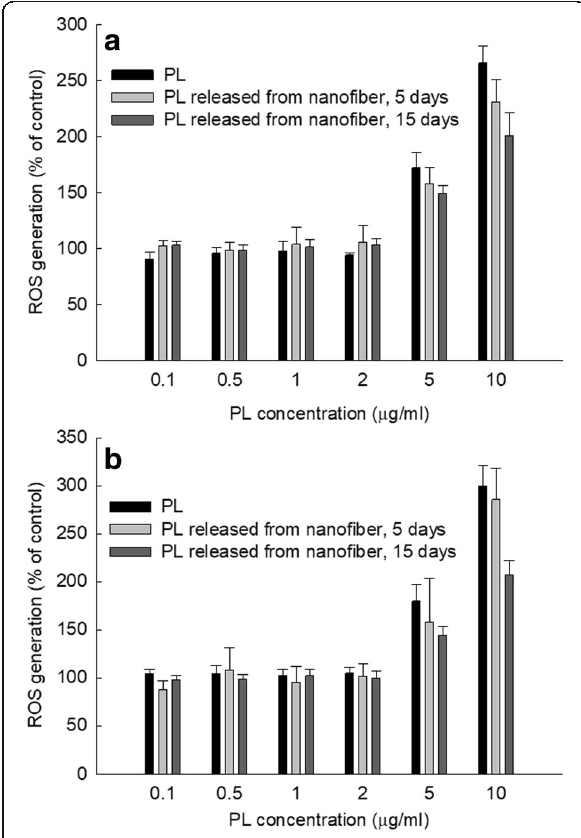
Fig. 5 The effect of PL and released PL from nanofiber mats on the ROS generation of HuCC-T1 cells ( a ) and SNU245 cells ( b ). PL itself and released PL were treated as described in Fig. 3